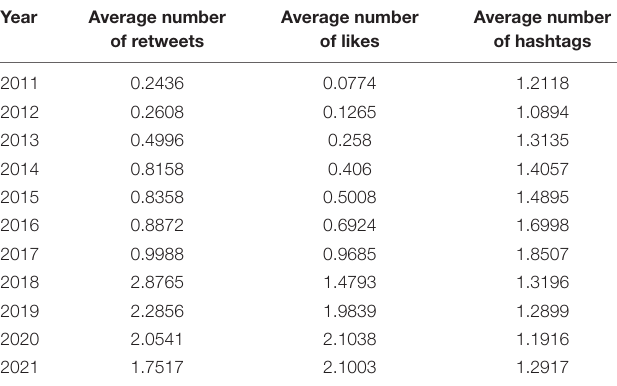
TABLE 1 | Breakdown of the average number of retweets, likes, and hashtags.